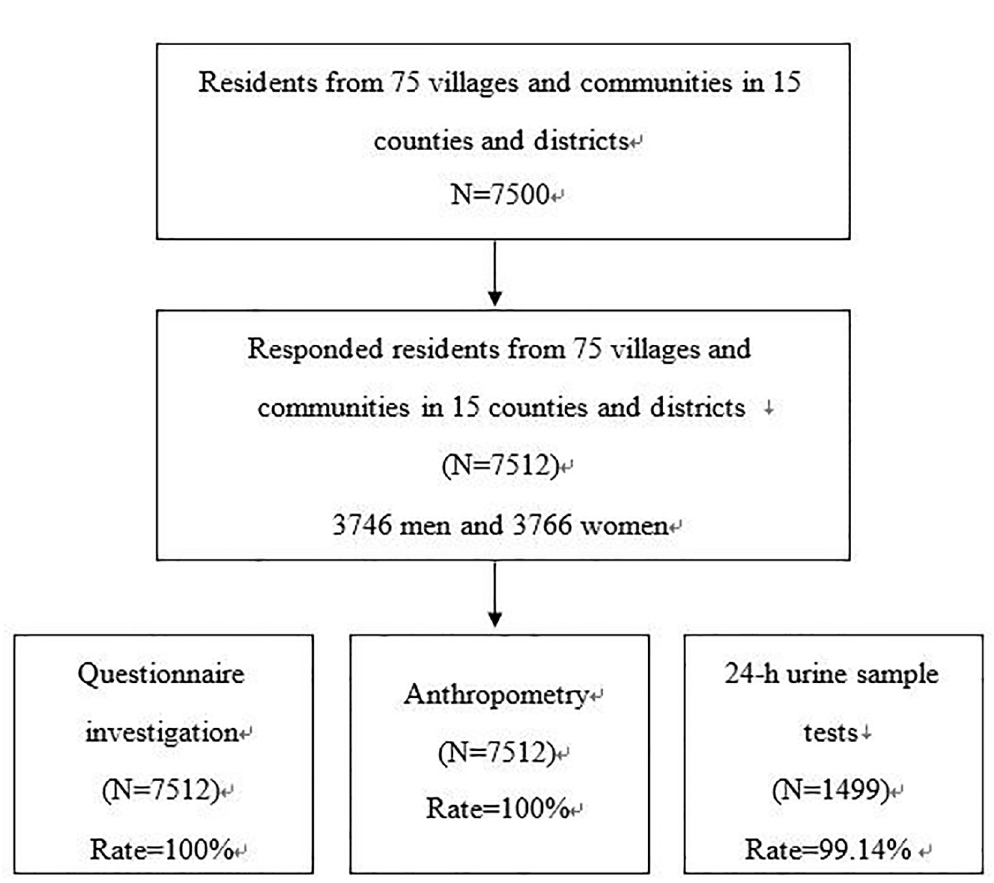
Fig 1. Study participants in the cross-sectional survey in Zhejiang Province of China in